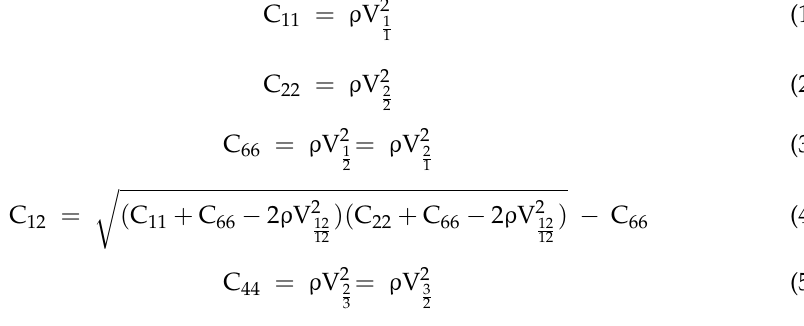
Table 1. The values of longitudinal and transverse velocity of the sample. Longitudinal Velocity Transverse Velocity Quasi Longitudinal or Quasi Transverse (m/s) (m/s) (m/s) V 1/1 = 9261.85 V 2/3 = 4960.5 V 12/12 = 4976.63 V 2/2 = 8013.51 V 1/2 =